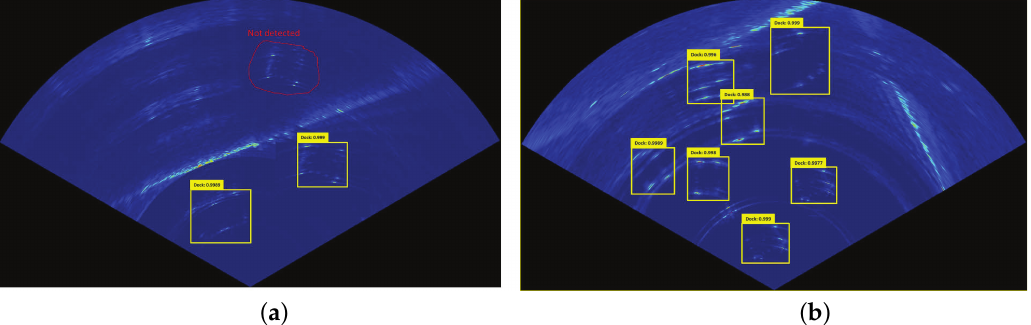
Figure 9. In ( a ) two annotations are correctly suggested and one is missed, which should be labeled manually. In ( b ) this image would take a long time to annotate manually. The primitive model has done a reasonable job of cutting out the bulk of the workload.